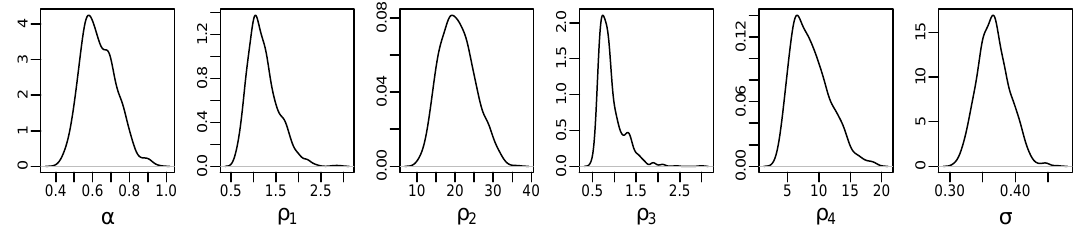
Figure 3. Posterior marginal density distributions of the hyperparameters: marginal variance α and length-scales ρ = ( ρ 1 , ρ 2 , ρ 3 , ρ 4 ) of the GP prior for the spline coefficients, and residual noise σ of the